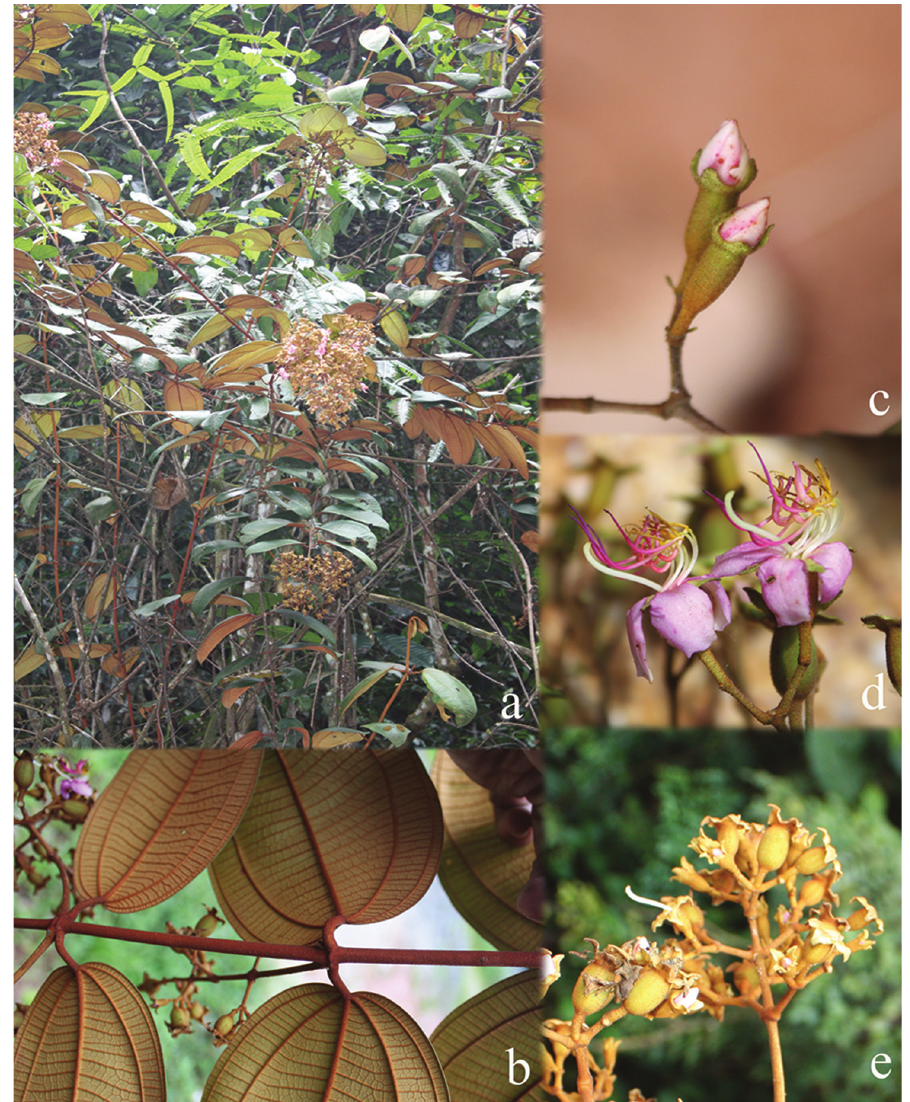
Figure 26. Dissochaeta spectabilis . a habit b branchlet c hypanthium d flowers e fruits. Photographs by A. Kartonegoro; vouchers: Kartonegoro 1100 (BO,